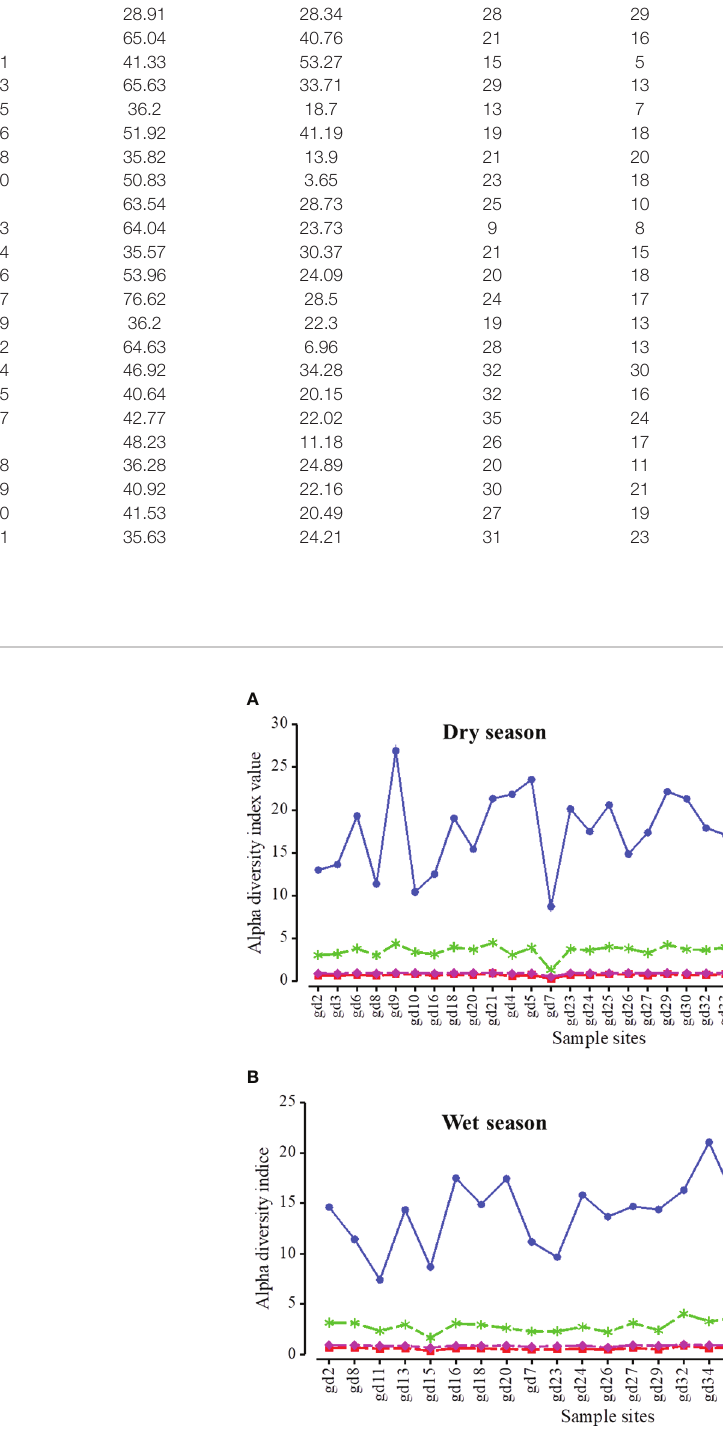
FIGURE 7 | The spatial distribution of phytoplankton alpha-diversity indices during dry (A) and wet (B) seasons. ( d = Margalef index; J ′ = Pielou index; H ′ = Shannon – Weaver index; 1 − l = Simpson